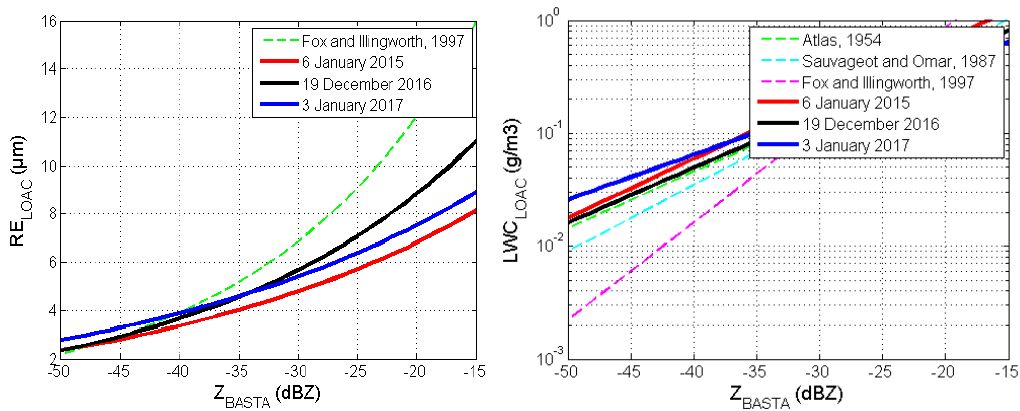
Figure 9. Parametrical relationship between LWC ( right ) or Re ( left ) and reflectivity for these three tethered balloon flights and previous studies (Atlas, 1954, Sauvageot and Omar, 1987, and Fox and Illingworth, 1997).